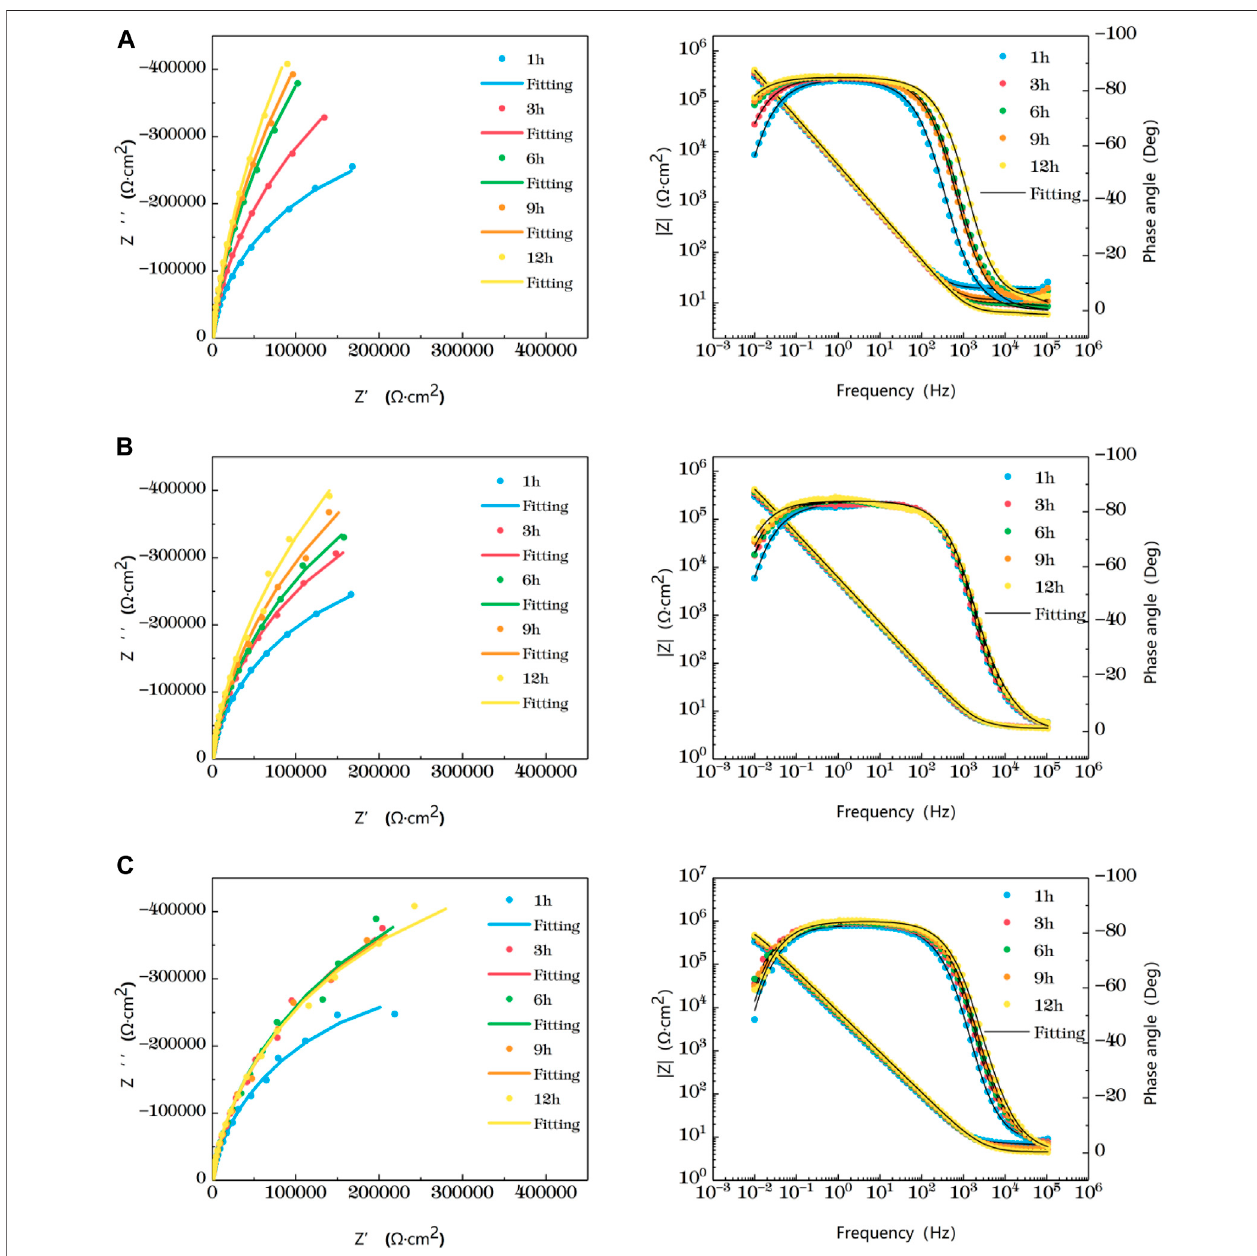
FIGURE 4 | Impedance change of the heat-affected zone after immersion in arti fi cial seawater at different temperatures for 12 h (A) 25 ° C (B) 35 ° C (C) 45 ° C.